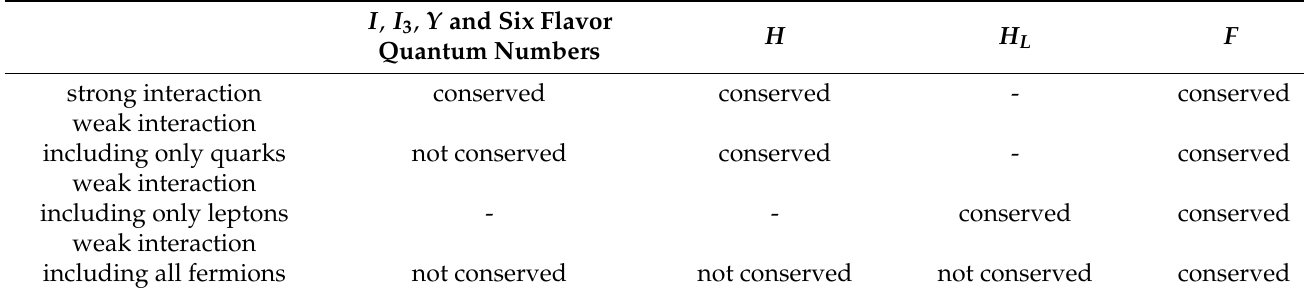
Table 3. Additive quantum numbers and conservations in different